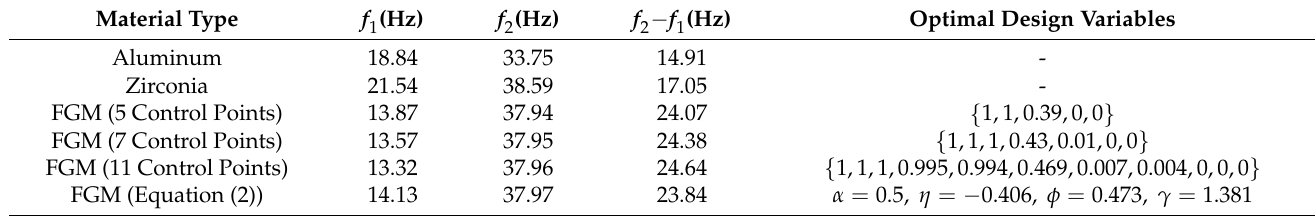
Table 7. The optimal frequencies and design variables of the second design